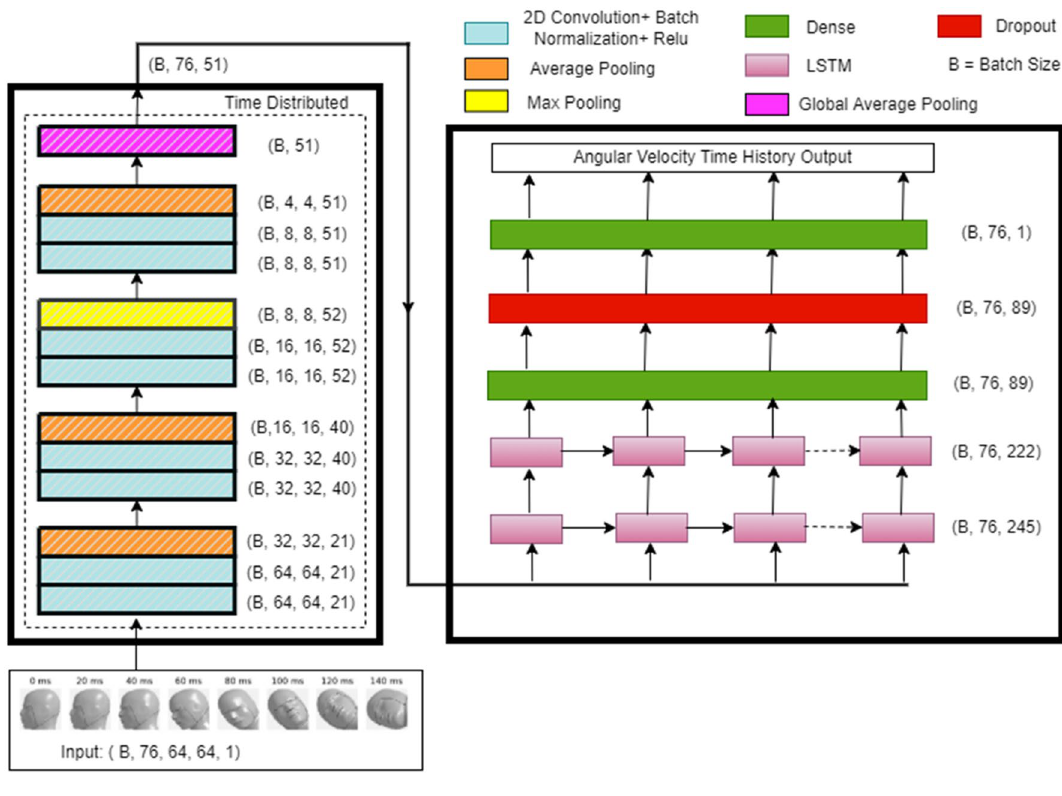
Figure 7. Final model architecture.